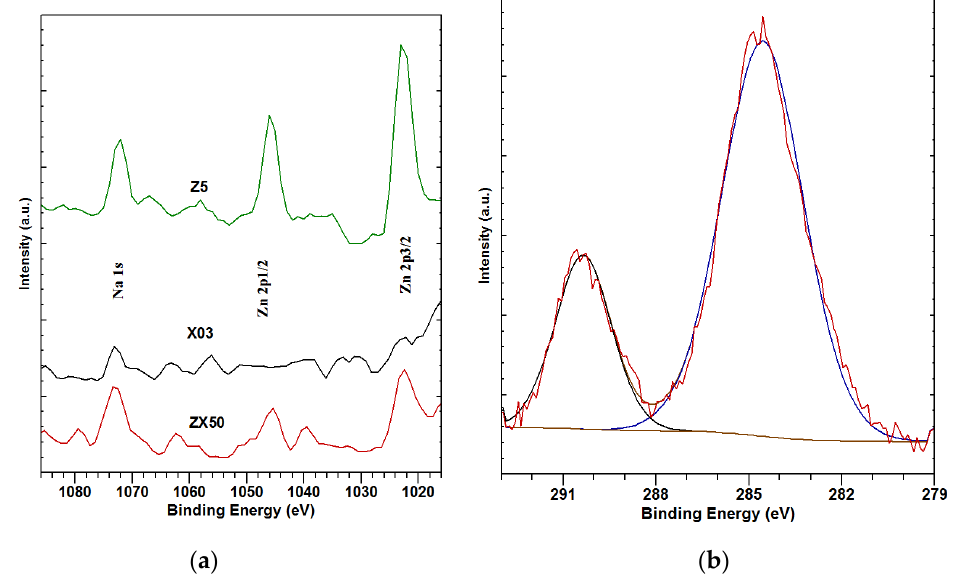
Figure 8. Narrow acquisition range XPS scans of 1016–1086 eV of the ZX50, X03 and Z5 alloys (from bottom to top) after immersion in SBF ( a ), and the HR XPS spectrum of C 1s fitted with components around 285 eV and 290 eV ( b ).